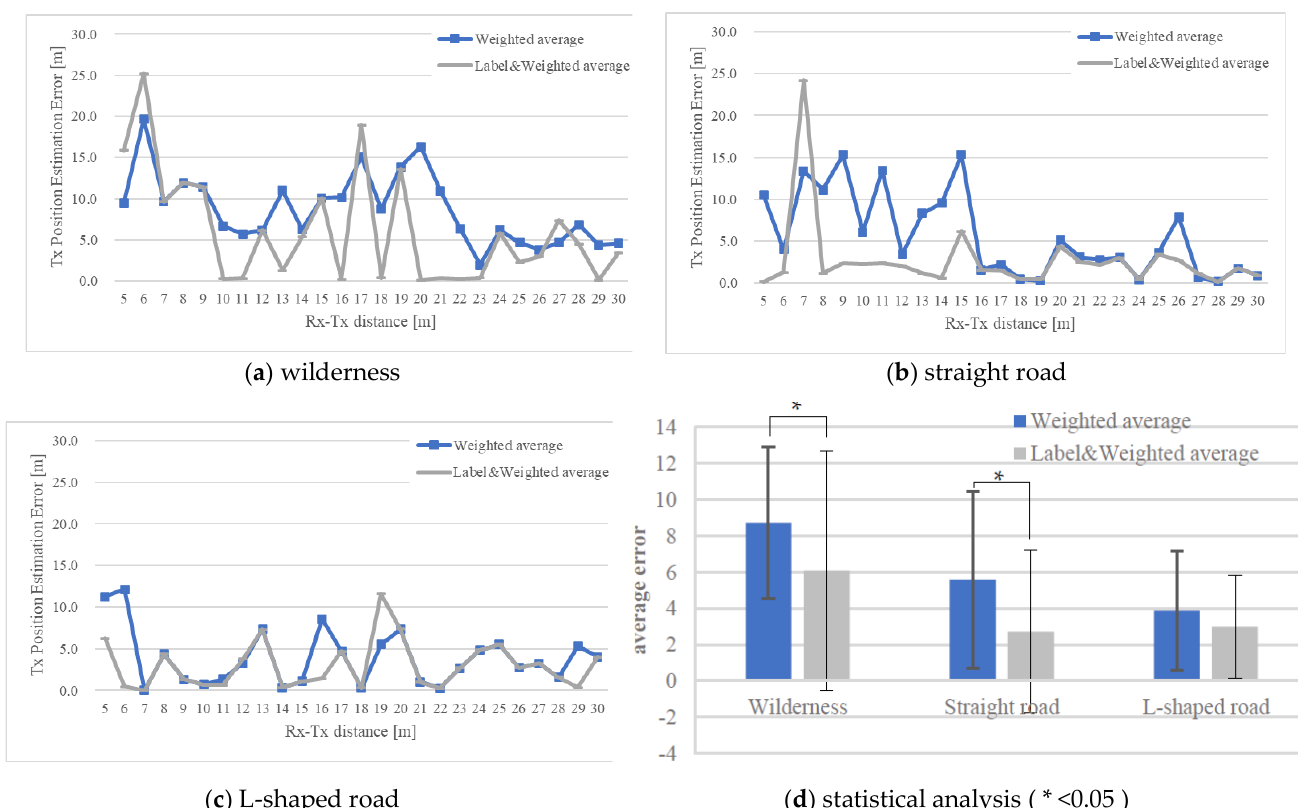
Figure 8. Position estimation results of the measurement simulation using the particle filter (three-step RSSI measurement). ( a ) wilderness; ( b ) straight road; ( c ); L-shaped road; ( d ) statistical analysis.